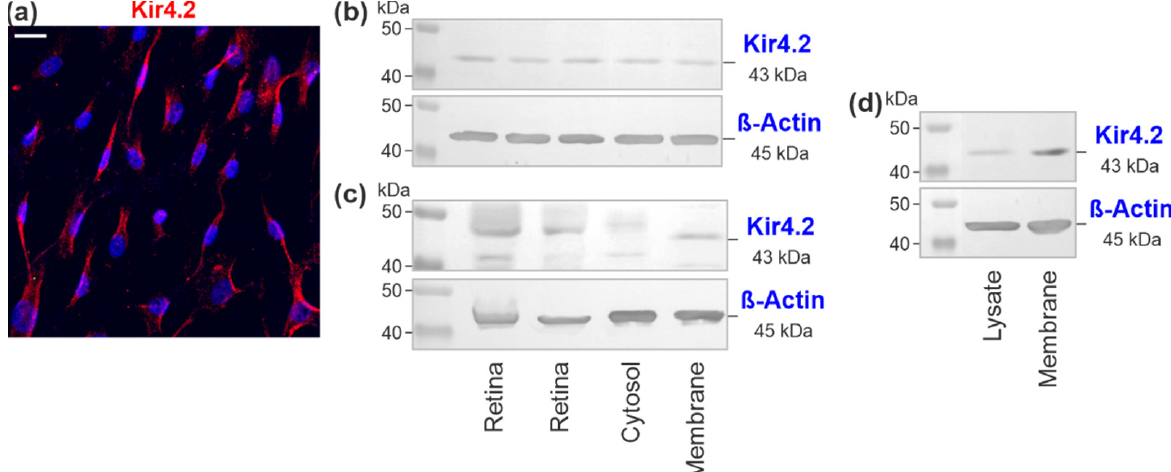
Figure 2. Kir4.2 protein in cultured human RPE cells. ( a ) Immunolabeling of a cell culture with an anti-Kir4.2 antibody ( red ). Cell nuclei were stained with DAPI ( blue ). Bar, 20 µm. ( b ) Western blot analysis of Kir4.2 protein performed with lysates of cells from five donors. ( c ) Western blots of Kir4.2 protein performed with lysates of acutely isolated neuroretinas from two post-mortem donors ( left side ) and cytosolic and membrane protein extracts of cells from one donor ( right side ). ( d ) Western blot of Kir4.2 protein performed with lysate and membrane protein extract of cells from one donor. ( a , c , d ) The images show one example of three experiments carried out using cells of different donors. The following antibodies were used for western blotting: rabbit anti-human Kir4.2 ( c ) and mouse anti-human Kir4.2 ( b , d ).